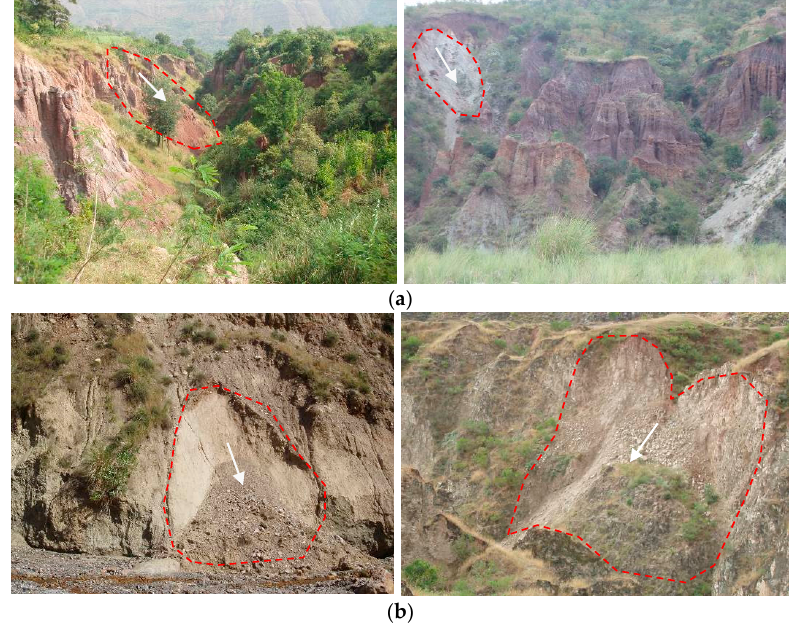
Figure 11. Landslides occurred in the study area. ( a ) landslides on the Quaternary deposits; ( b ) landslides on the fine sand layer.